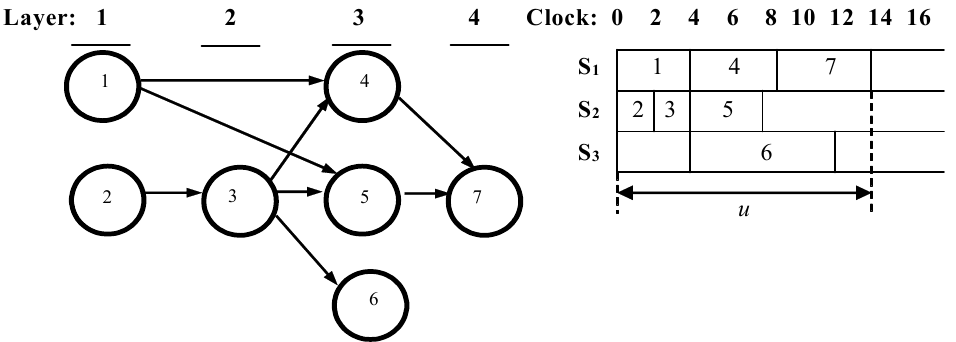
Figure 8. Graph interpretation of the dispatching plan based on results obtained from GGSA and PATH execution.